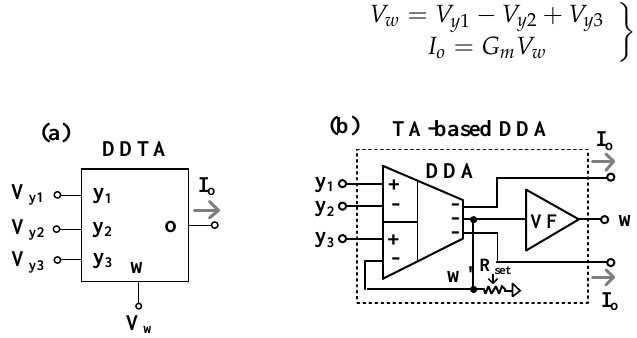
Figure 1. TA-based DDA: ( a ) symbol; ( b ) internal structure.